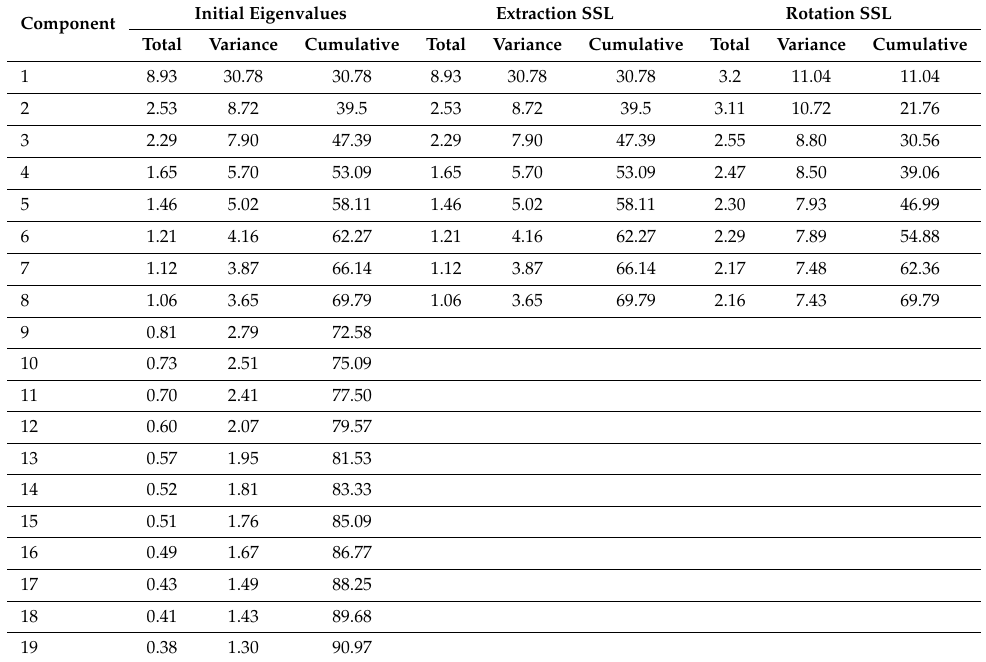
Table 5. Total variance explained. Note that variance and cumulative are percentages and SSL is sum of squared